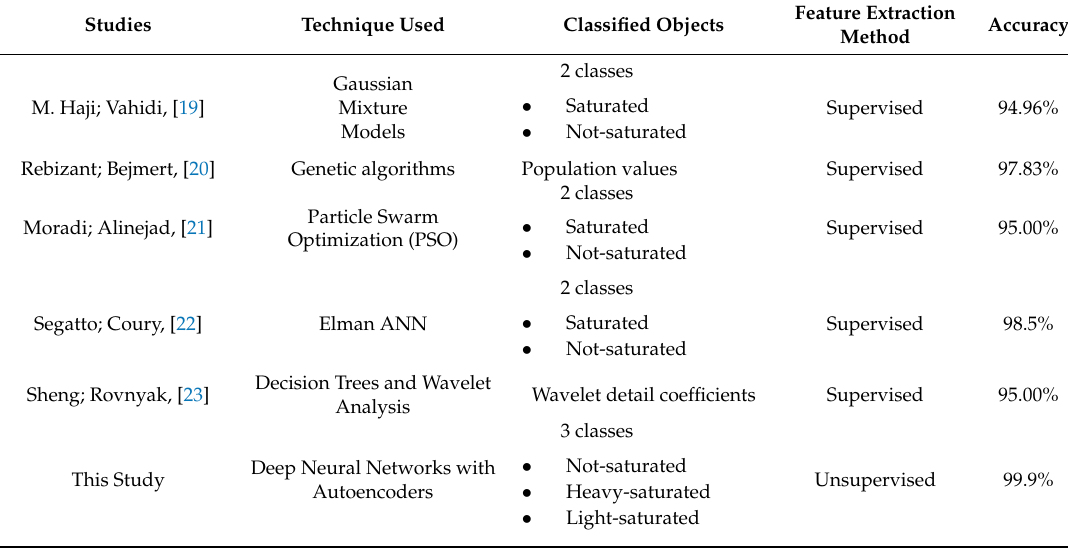
Table 1. Summary of past research based on artificial intelligence (AI)